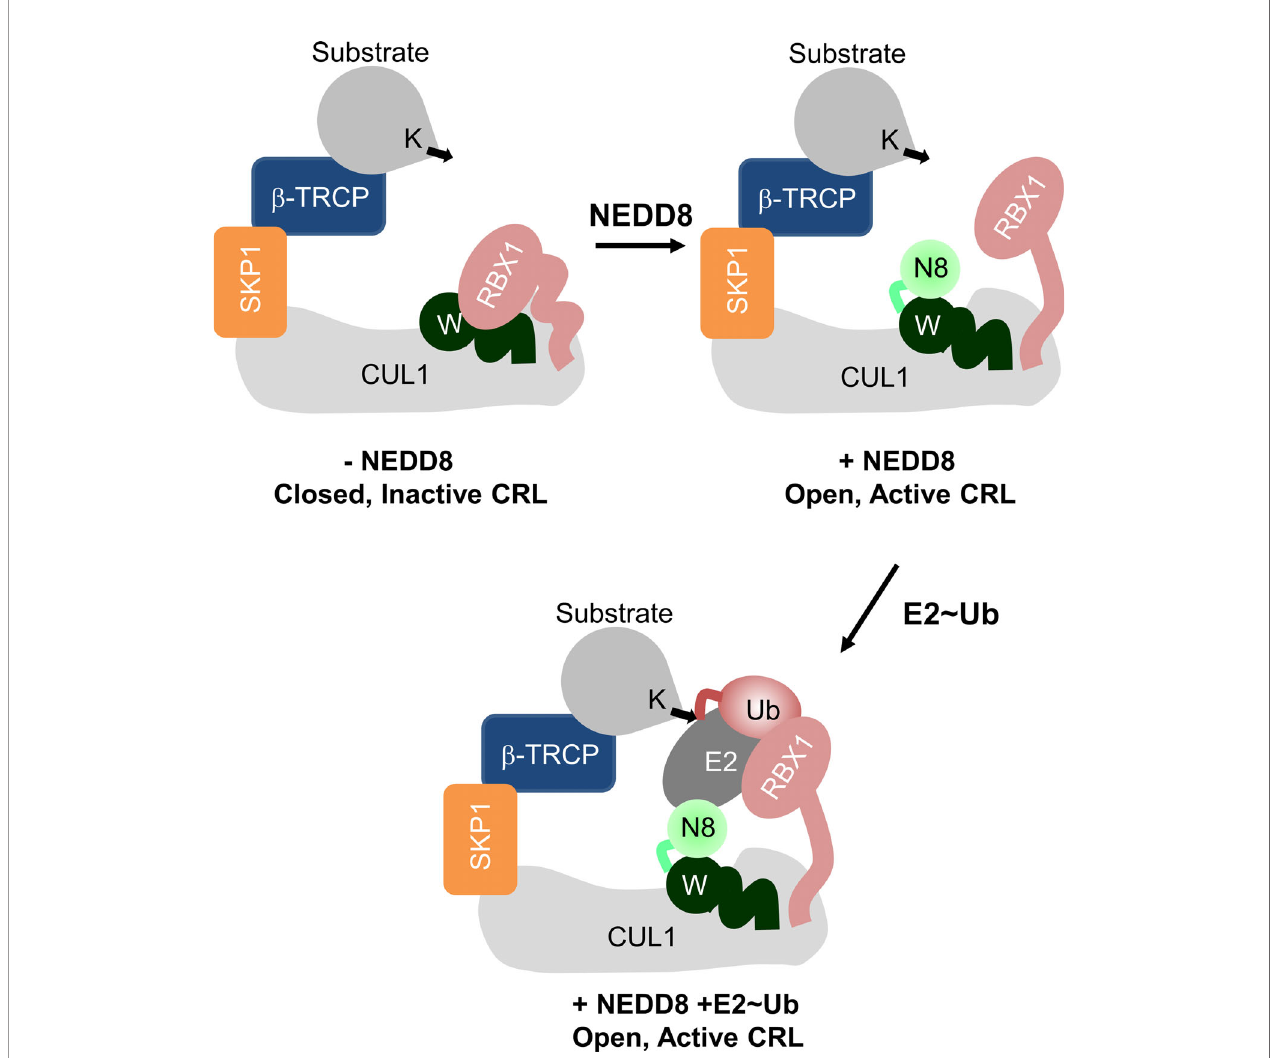
FIGURE 1 | Role of NEDD8 in the activation of Cullin RING ligases. Schematic illustration showing the mechanism of Cullin RING ligase activation by NEDDylation. Conjugation of NEDD8 (N8) to the WHB SD (W) triggers a change in its orientation which frees the Rbx RING domain from inhibitory